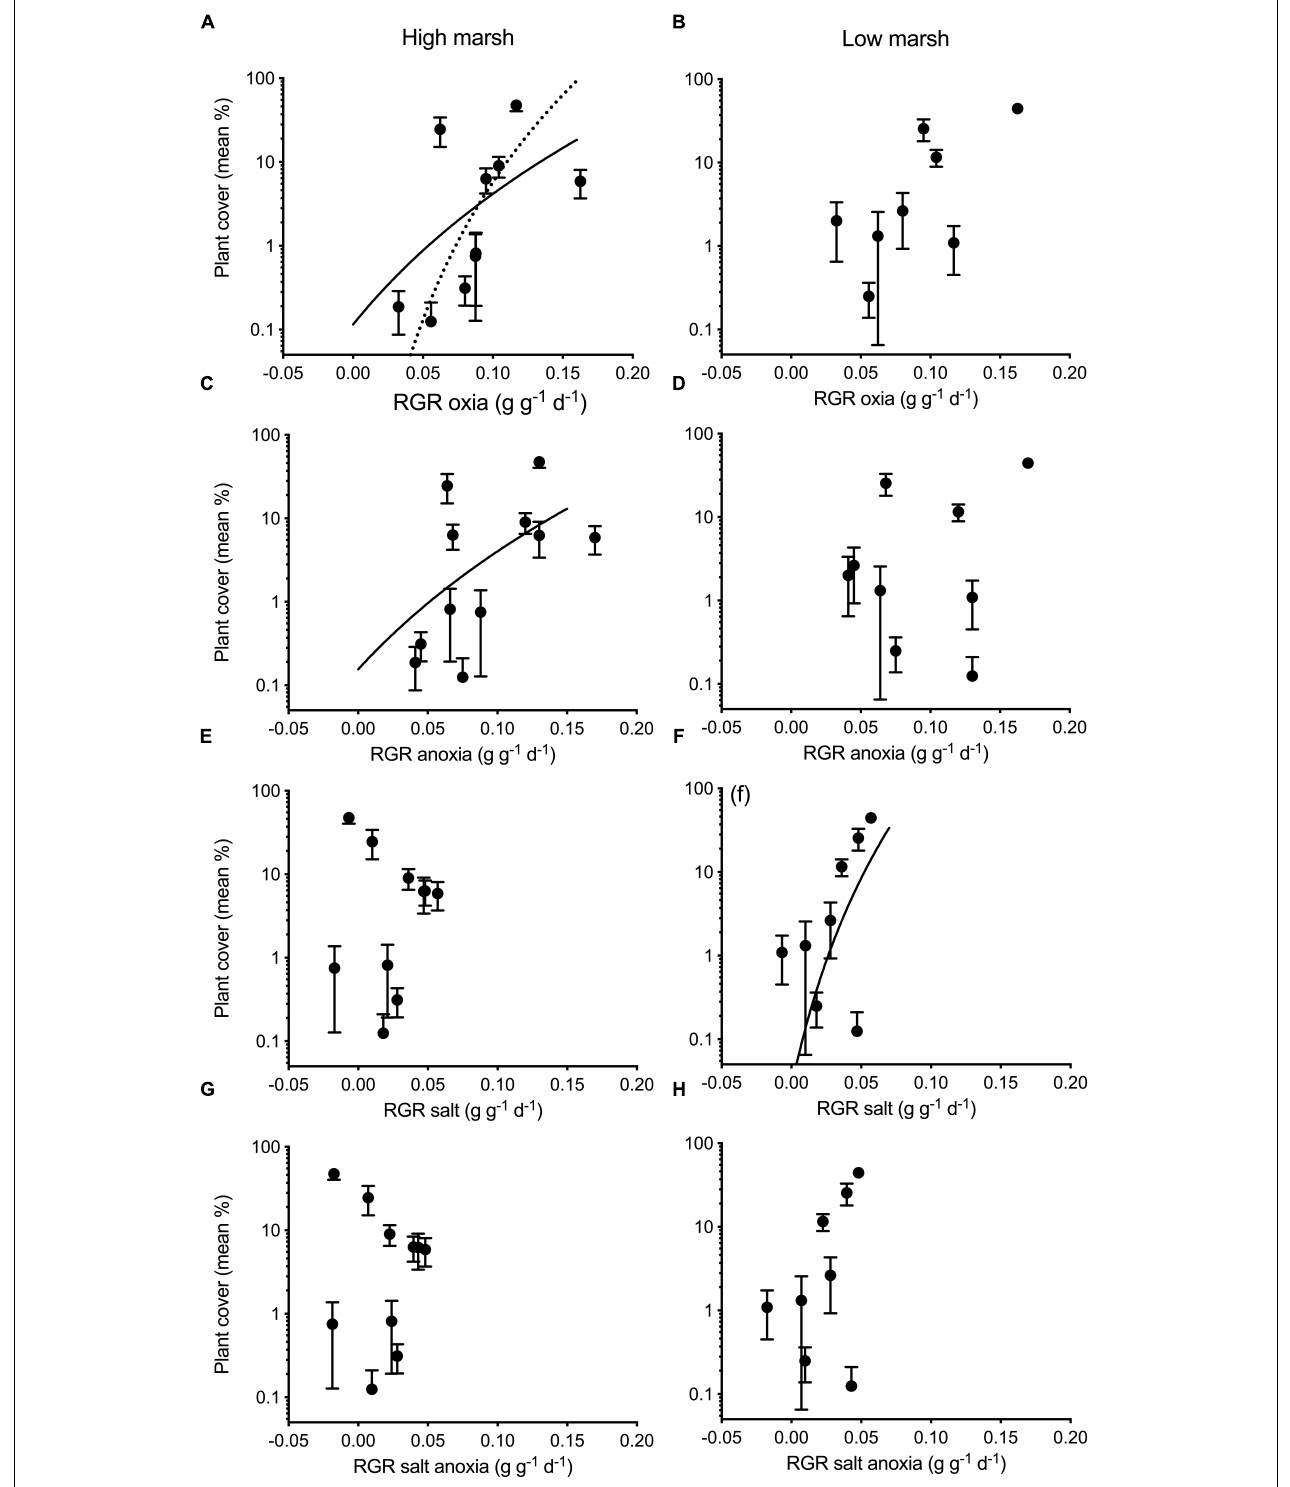
FIGURE 3 | Plant cover per species (%) of the high (A,C,E,G) and low (B,D,F,H) salt marsh as a function of the mean FW relative growth rate (g g − 1 d − 1 ) for different treatments of the oxygen (A–D) and salt (E–H) experiment. The dotted lines in A,G show the correlation when Puccinellia maritima and Elytrigia atherica are not taken into account ( A,C,E,G , n = 11; B,D,F,H , n = 10). Festuca rubra and Potentilla anserina were not present on the low marsh and not displayed in graphs B,D,F,H . The error bars denote 1SD. Outcomes of the Pearson product-moment correlation tests are listed in Table 4 .